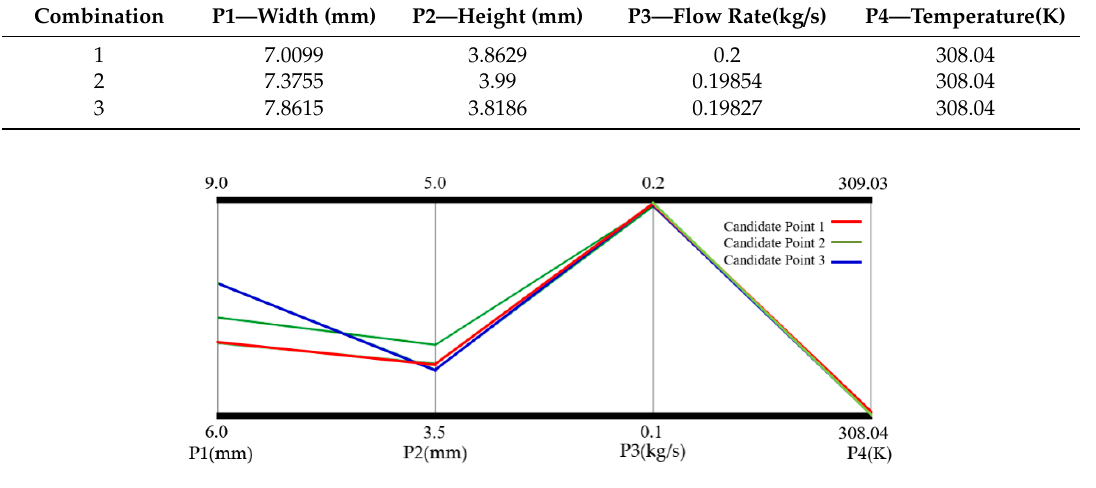
Figure 13. Optimal dimension parameter combination.